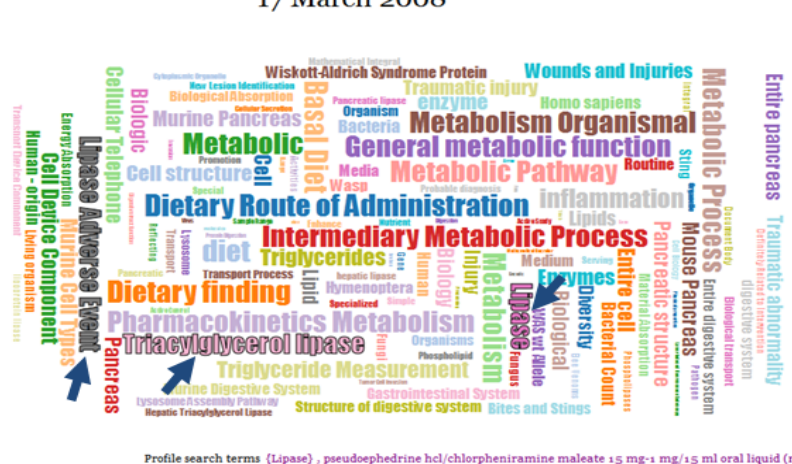
Figure 8. Short Term Profile cloud—Search.